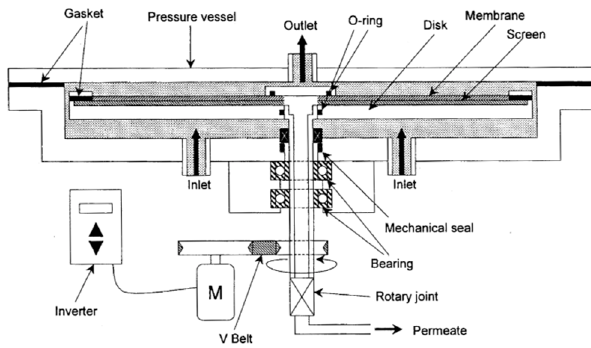
Figure 1. Details of rotating membrane separation apparatus.